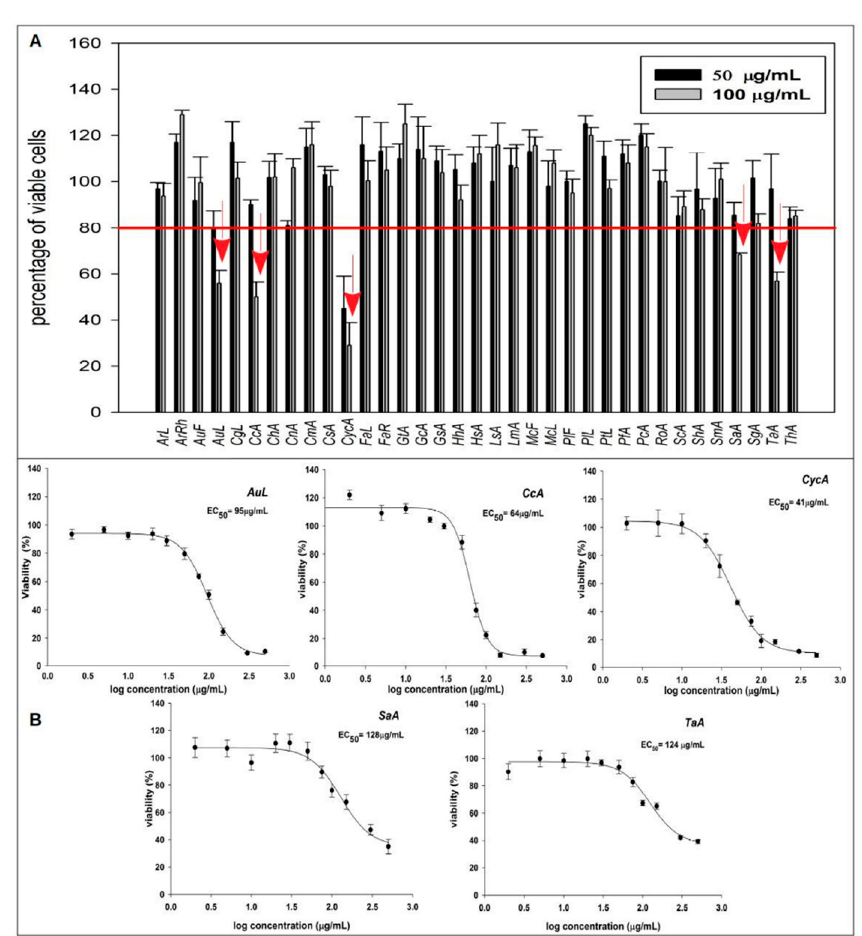
Figure 1. Antiproliferative e ff ects of plant extracts on U2OS cells. ( A ) Screening of all extracts on viability of U2OS cells treated at 50 and 100 µ g / mL concentrations. Bars indicate the means of six replicated experiments and represent the percentage of viable cells with respect to the control taken arbitrarily as 100%. ( B ) Dose–response curves of U2OS cell viability after treatment with the five most active extracts for 48 h.